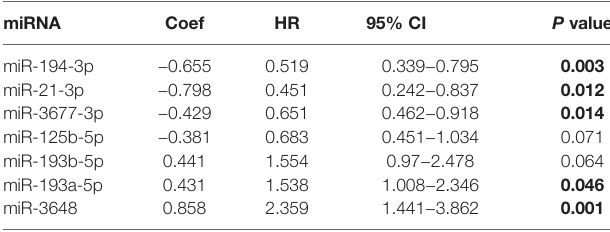
TABLE 2 | Parameters in the prognostic risk score* for COAD based on the expression of seven